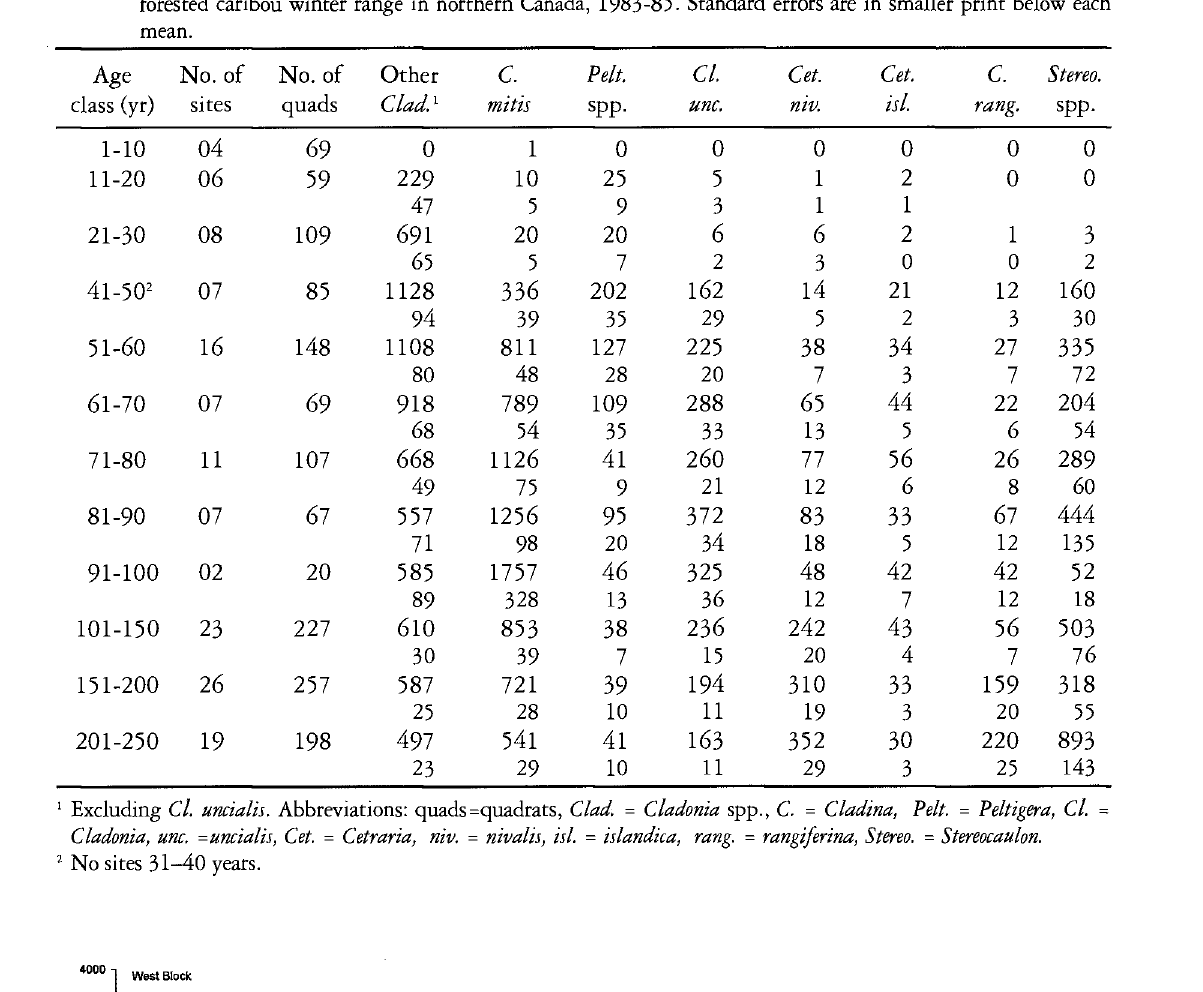
Table 1. Mean biomass (kg/ha) of lichen species in quadrats at 10- and 50-year intervals after fire in the west block of forested caribou winter range in northern Canada, 1983-85. Standard errors are in smaller print below each mean. Age No. of Other C. Pelt. CI. Cet. Cet. C. Stereo. Clad. 1 mitts spp. une. niv. isl. rang. spp.